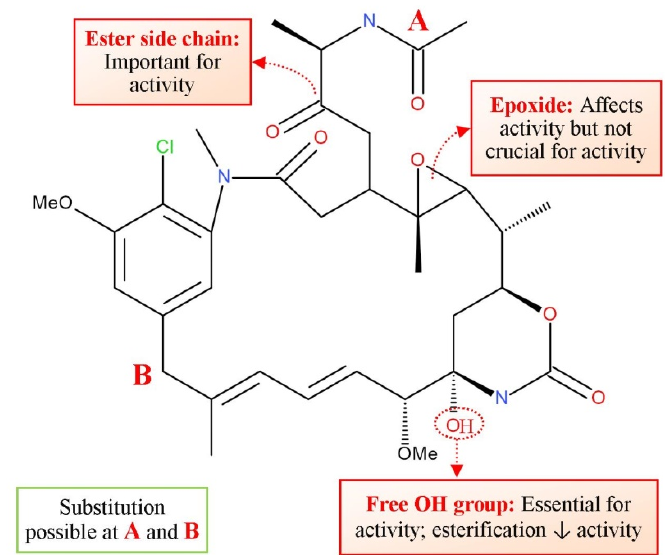
Figure 14. SAR of